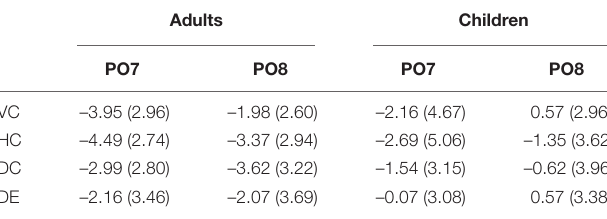
Table 4 for a summary of the behavioral and N170